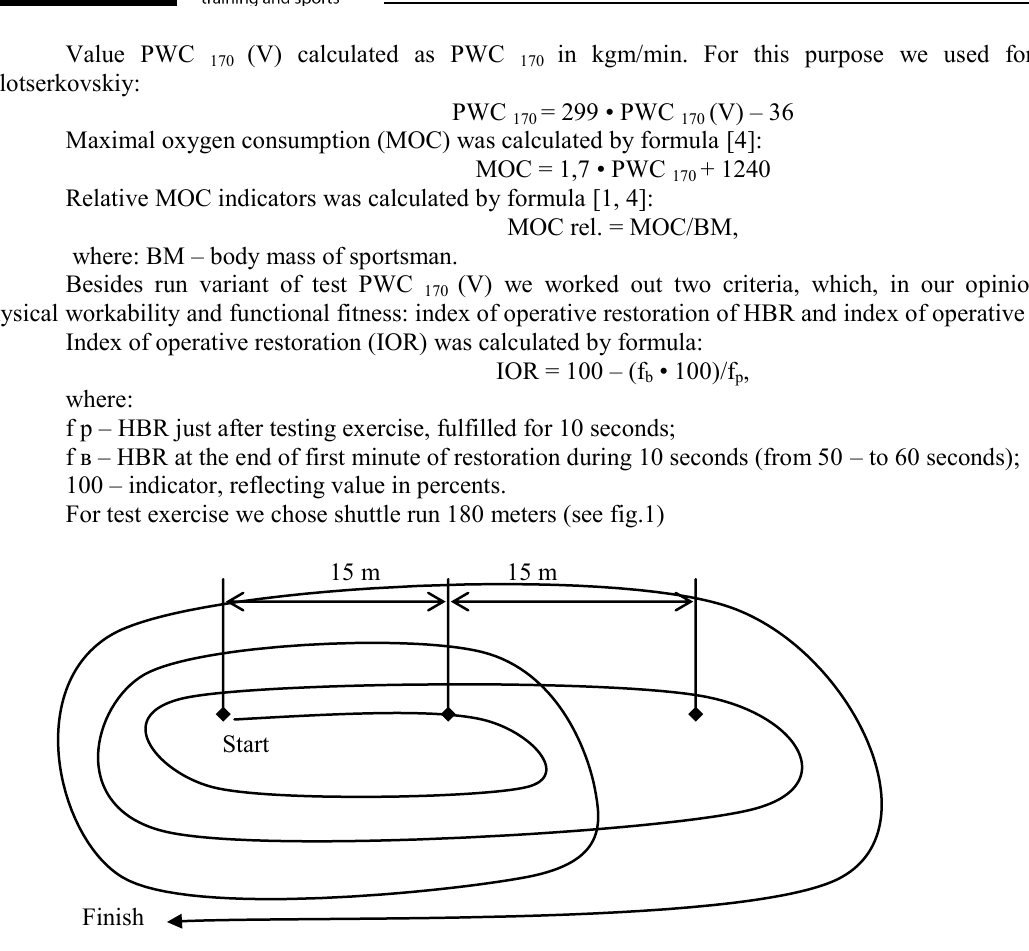
Fig.1. Diagram of test “shuttle run 180